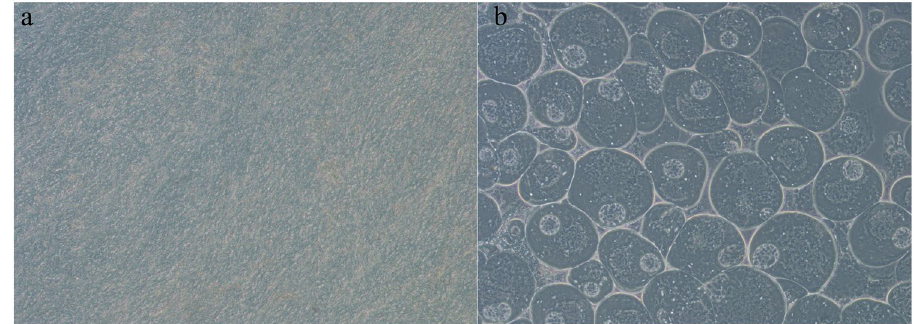
Figure 1. Micrographs of testis and ovary from 18-month-old grass carp. ( a ) Micrograph of testis in 10 × magnification. ( b ) Micrograph of ovary gonad in 10 ×